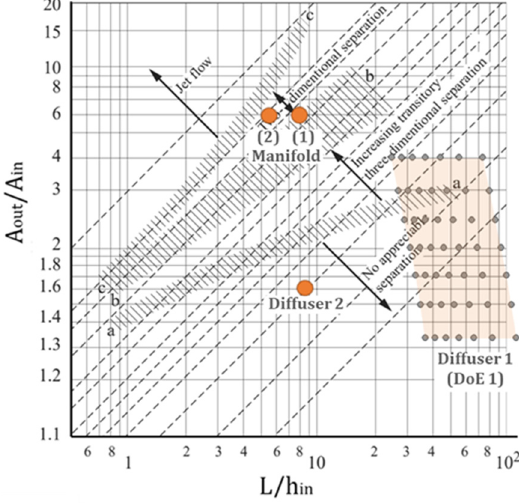
Figure 16. Flow regimes for plane-walled, single-plane expansion diffusers [30].